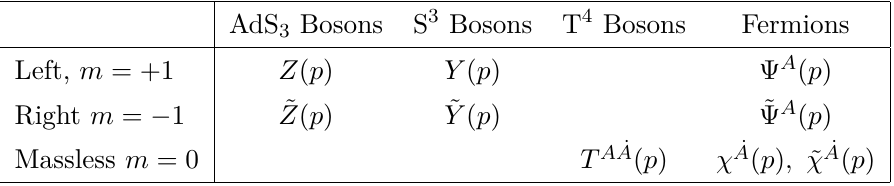
Table 1 . The fundamental particles of AdS 3 × S 3 × T 4 are eight Bosons and eight Fermions.